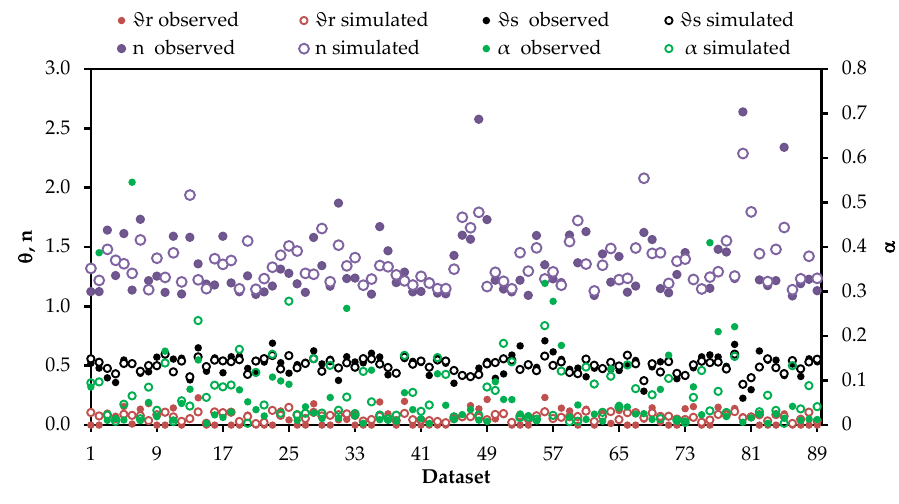
Figure 4. Observed and simulated vG parameters obtained by ANN1.